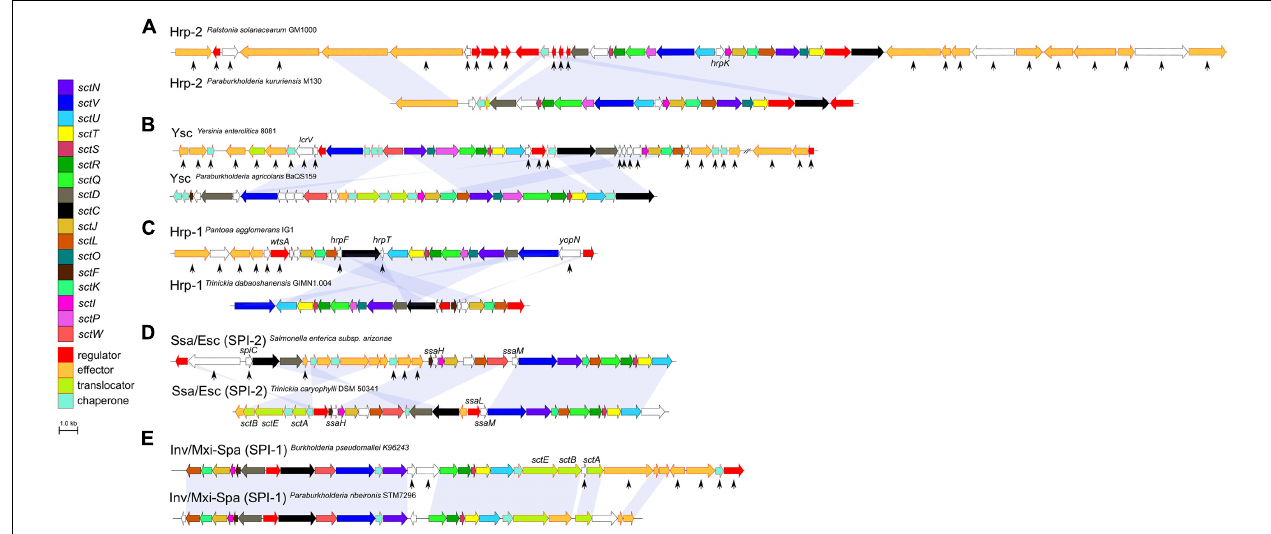
FIGURE 4 | Loss of accessory genes in T3SS synteny blocks of Burkholderia s.l. species. The Hrp-2 type (A) is the most frequent T3SS in Burkholderia s.l. species. The Ysc (B) , Hrp-1 (C) and SPI-2 (D) are T3SS types which rarely occur in Burkholderia s.l. species. The SPI-1 type (E) is only represented in a single Paraburkholderia species. In each case, several genes coding for effectors and chaperones as well as proteins with unknown functions are lost (black arrows) compared to pathogens were these genes have a described role in